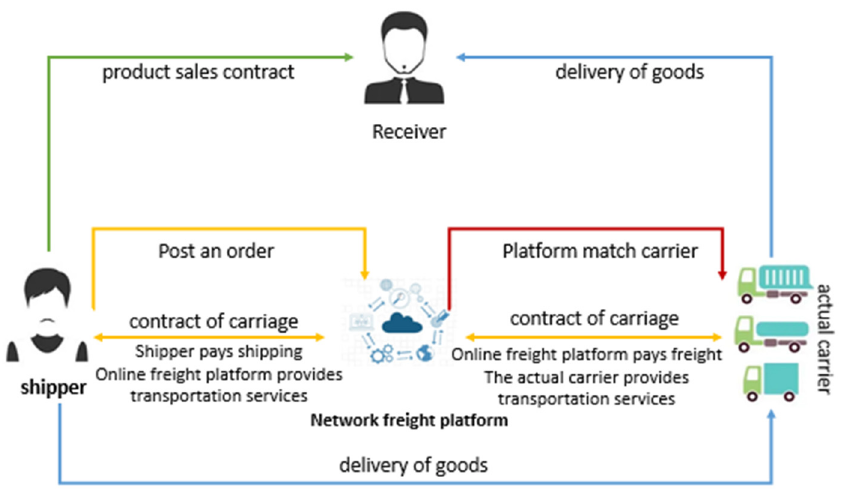
Figure 1. Operation principle diagram of the network freight platform.